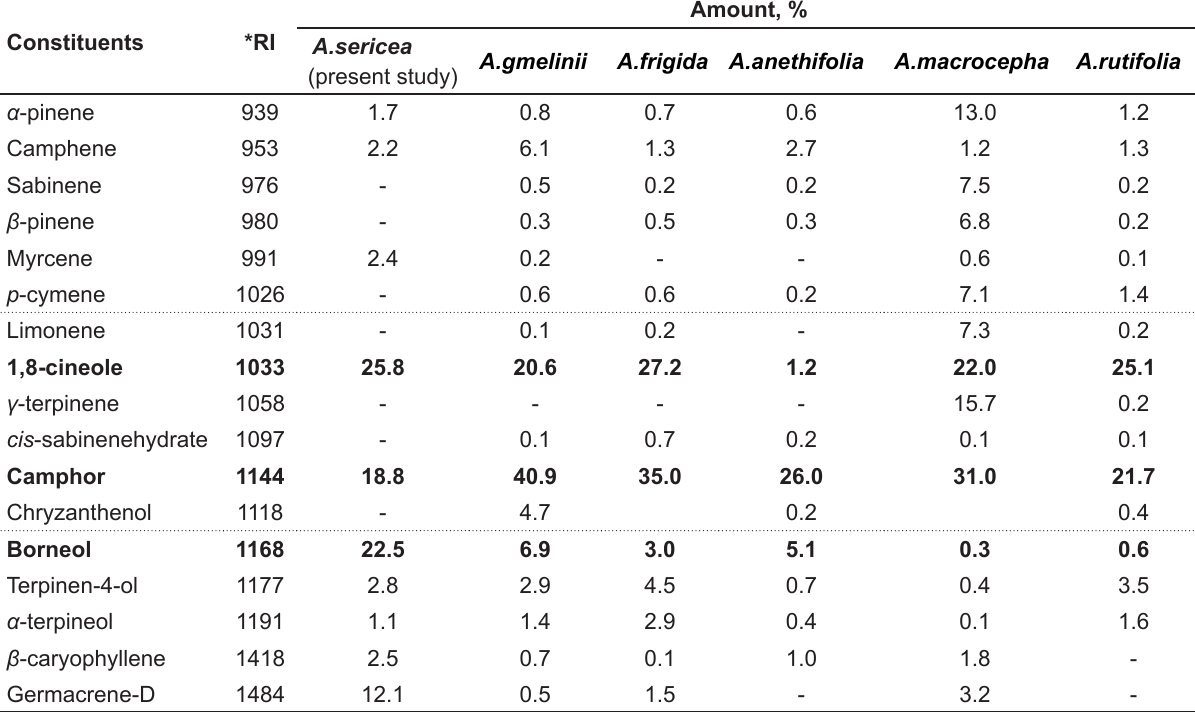
Table 3. Essential oils constituents of some Artemisia species-rich with 1,8-cineole, borneol, and